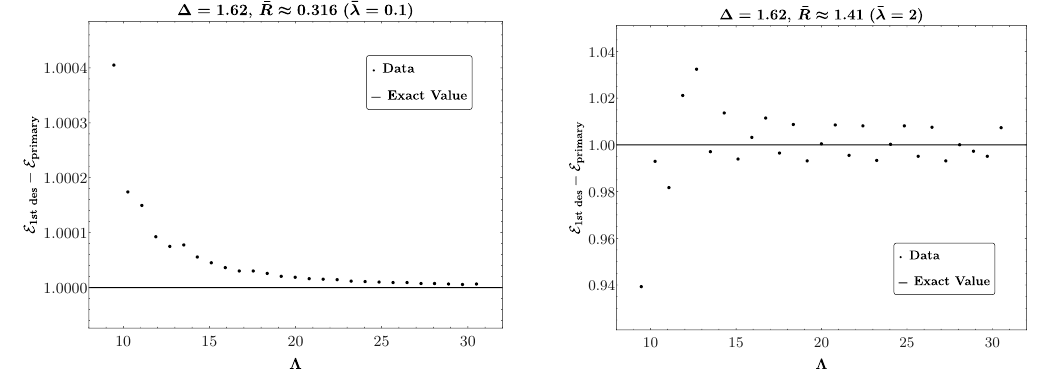
Figure 10. Difference of energies between the first primary state | χ i and its first descendant, verifying that the SL(2 , R ) spacetime symmetry of AdS is restored in the continuum limit Λ → ∞ .